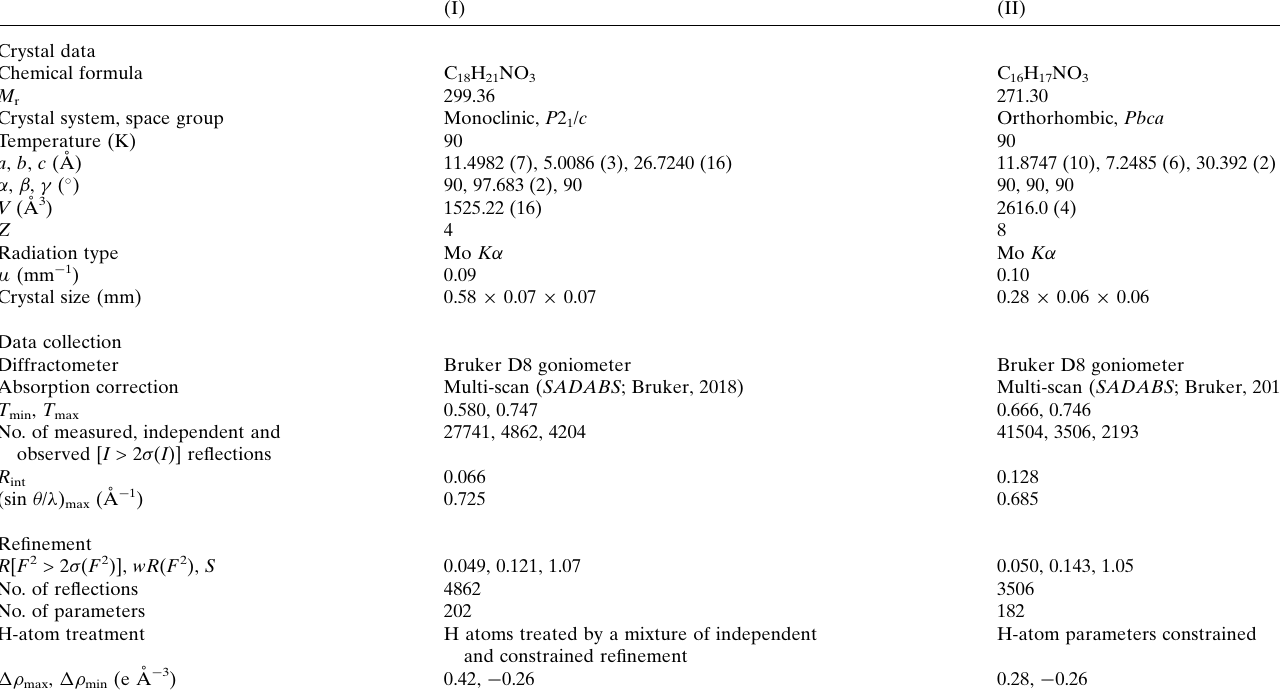
Table 3 Experimental details.